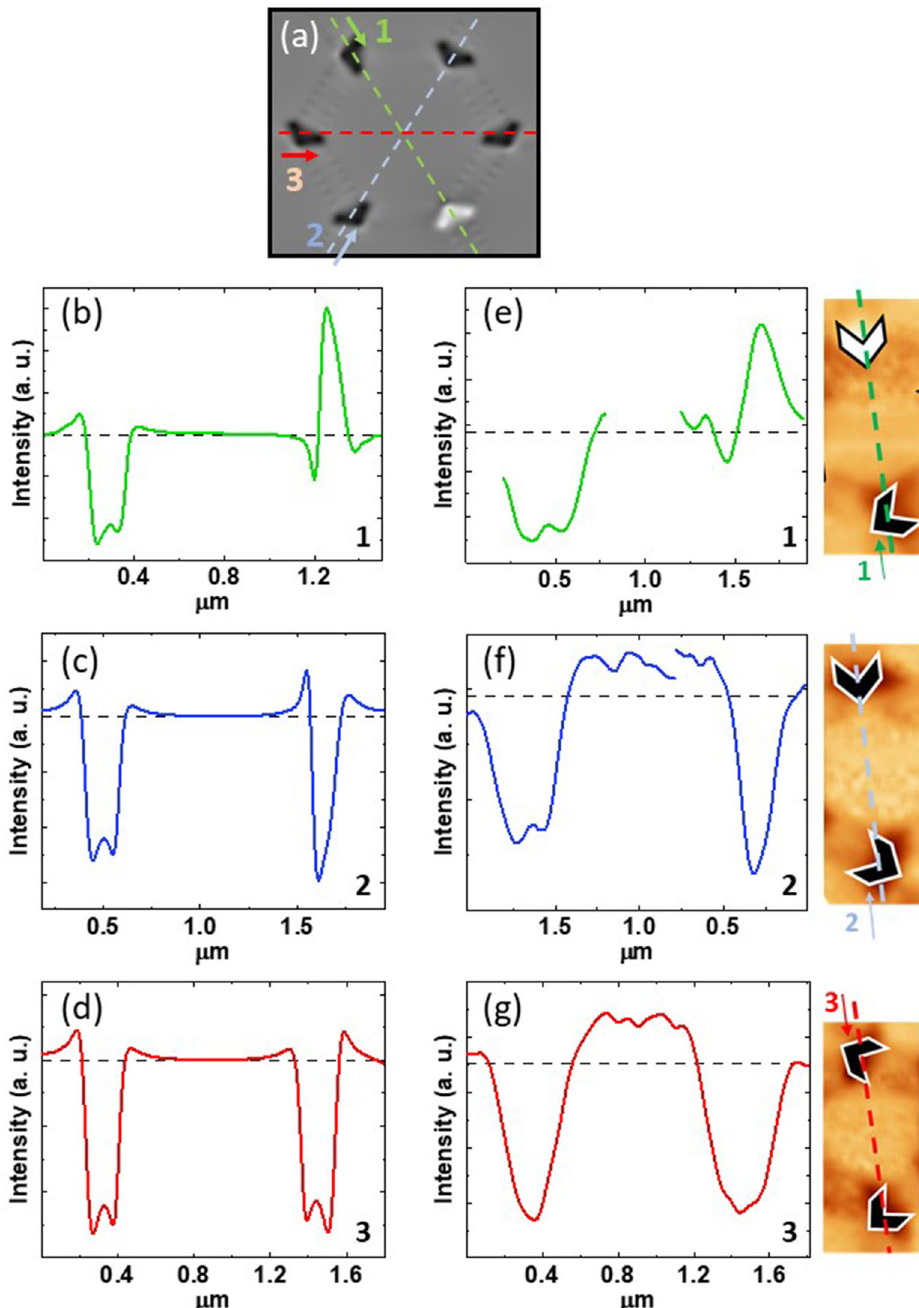
Figure 5. ( a ) Hexagonal unit cell extracted from simulation of the spin ice array in Ice I configuration. The black and white nanotriangles correspond to + 1 and −1 spin ice charges, respectively. The 1, 2, 3 dashed lines correspond to possible vortex trajectories. ( b )–( d ) simulated profiles along 1, 2 and 3 trajectories respectively. ( e )–( g ) experimental profiles from experimental MFM images. They are taken from the MFM images placed to the right of the respective panels. The ( e ), ( f ) and ( g ) panels correspond to the same ( a ) trajectories 1, 2, 3 as the ones in the simulated profiles ( b )–( d